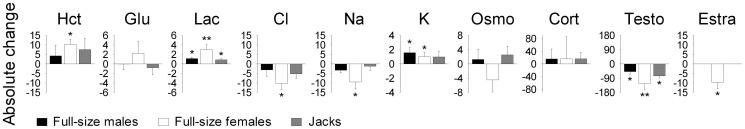
Changes in blood parameters of coho salmon (O. kisutch) upon exposure to an acute temperature increase from 7 to 20°C.Full-size males, full-size females, and jacks are presented (N given in 
Materials and methods
). The blood parameters and their corresponding units are: Hct (haematocrit, %), Glu (glucose, mmol l−1), Lac (lactate, mmol l−1), Cl (chloride, mmol l−1), Na (sodium, mmol l−1), K (potassium, mmol l−1), Osmo (osmolality, mOsm kg−1), Cort (cortisol, ng ml−1), Testo (testosterone, ng ml−1), and Estra (17β-estradiol, ng ml−1). All variables were measured in blood plasma, except Hct which was measured in whole blood. Two-way ANOVA was used for statistical comparisons (see Statistics). * significantly different from zero (i.e., significantly different from the control group held at 7°C) at the level of P<0.05; ** significantly different from zero at the level of P<0.001. Full-size males and jacks did not differ in any blood parameter within the 7°C group or within the 20°C group. The only difference between these two groups was that full-size males had a significant increase in plasma potassium from 7 to 20°C, whereas jacks did not.